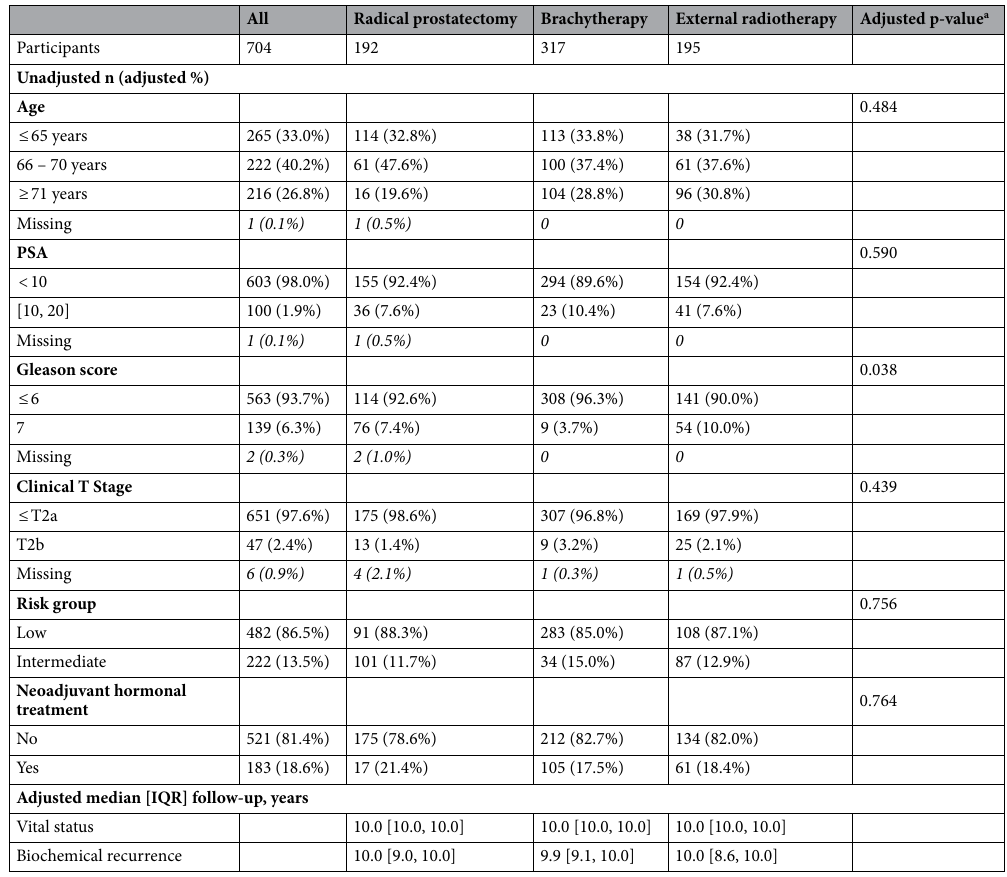
Table 1. Baseline characteristics by treatment: unadjusted n and adjusted percentages with propensity scores, and median [IQR] follow-up. a p-value was obtained with likelihood ratio test. Follow-up was calculated in years. IQR interquartile range, PSA prostate-specific